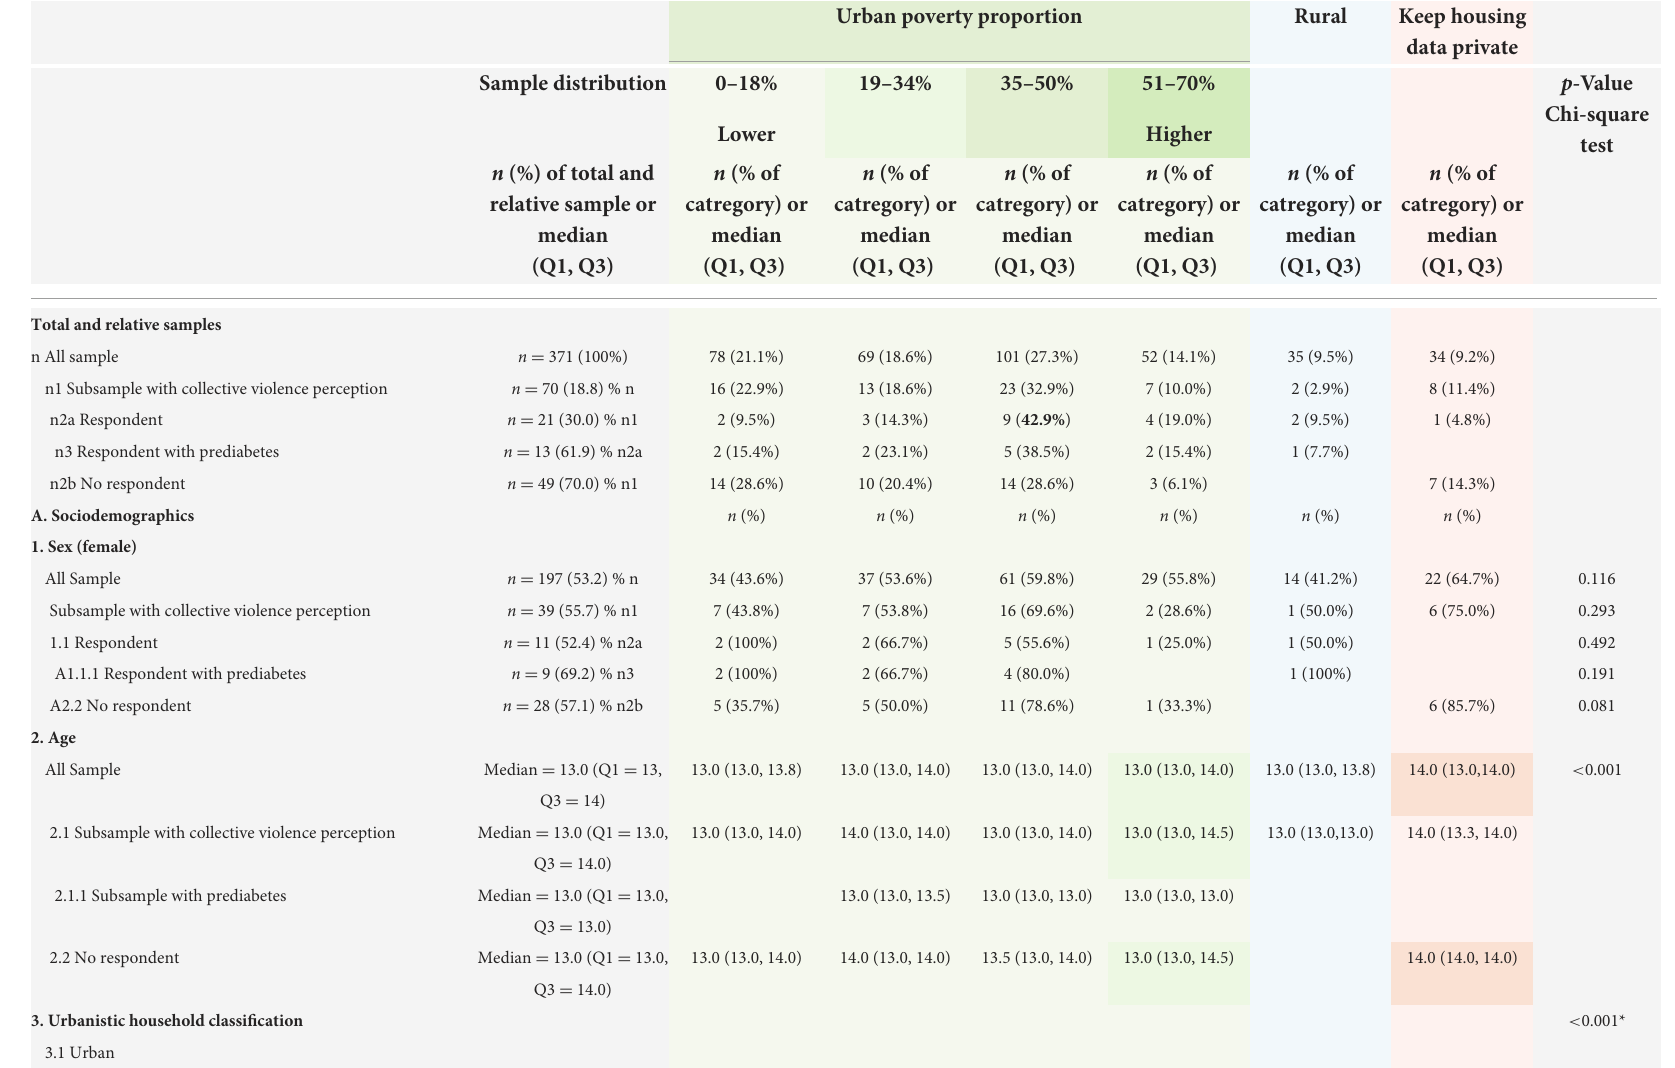
TABLE 1 Sociodemographic features by urban poverty sector among the